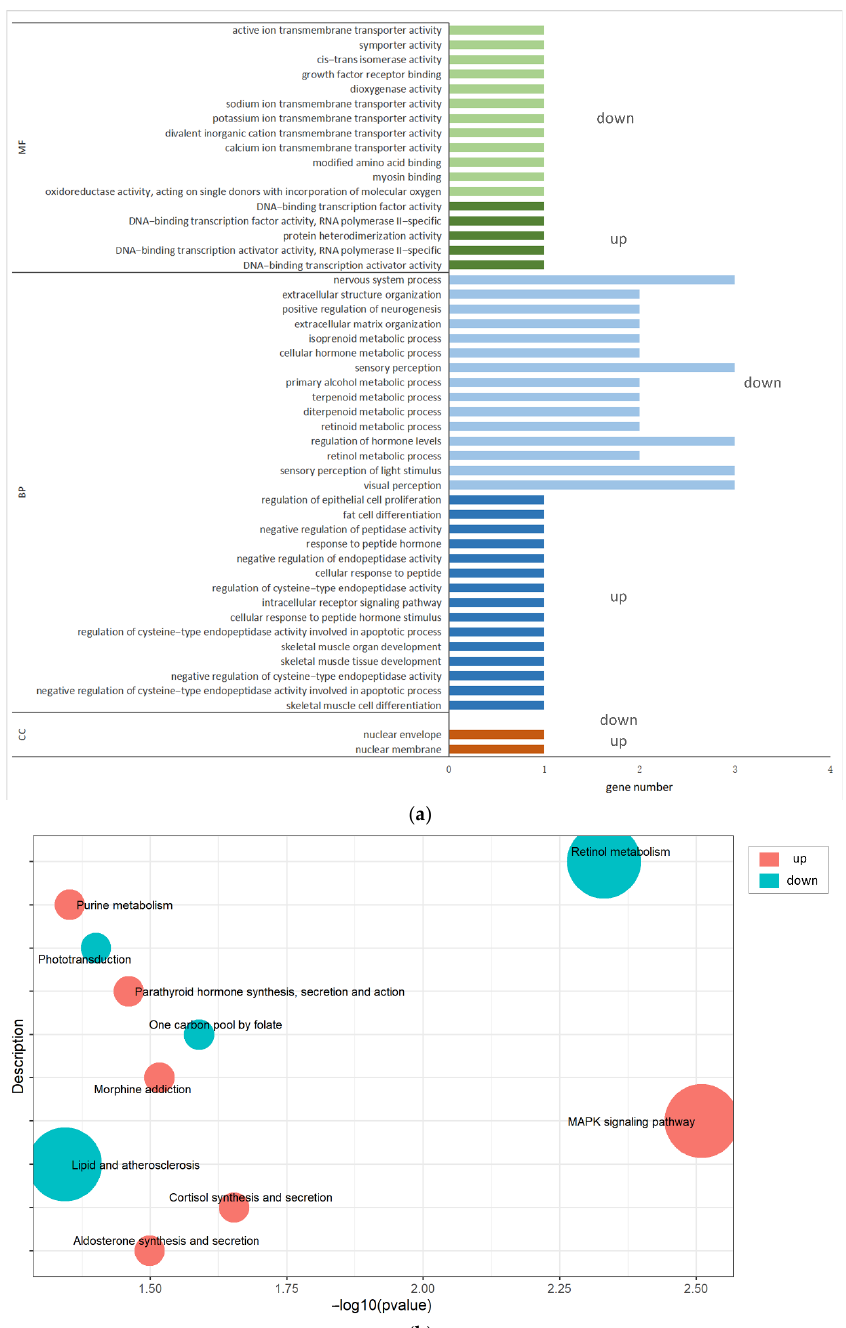
Figure 5. GO enrichment and KEGG signaling pathway analysis of the DIE-mRNAs in bMECs after miR-375 silencing. ( a ) GO enrichment of the DIE-mRNAs in bMECs ( p < 0.05). ( b ) KEGG enrichment analysis of the DIE-mRNAs in bMECs ( p <